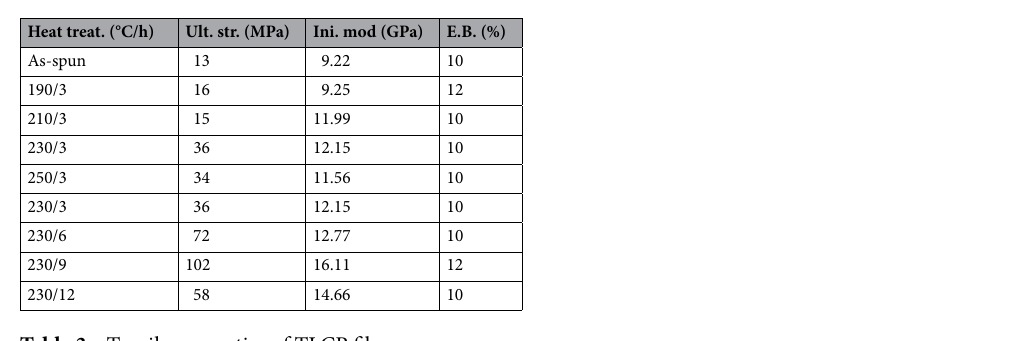
Table 3. Tensile properties of TLCP